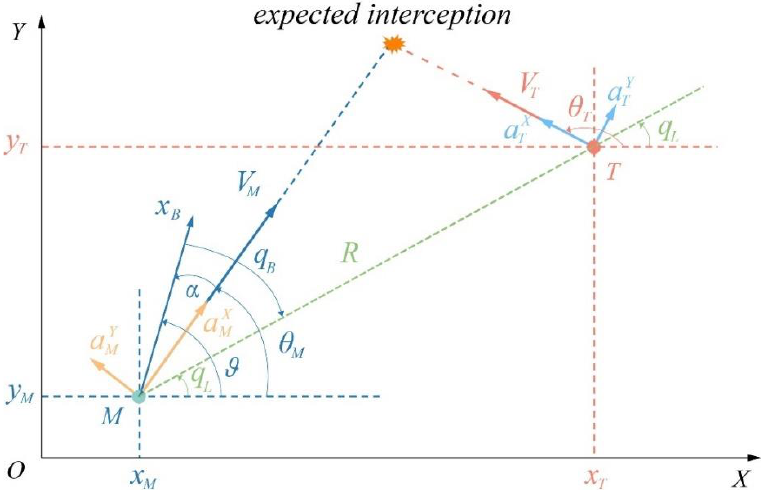
Figure 1. Two-dimensional missile – target engagement geometry for the strapdown missile.